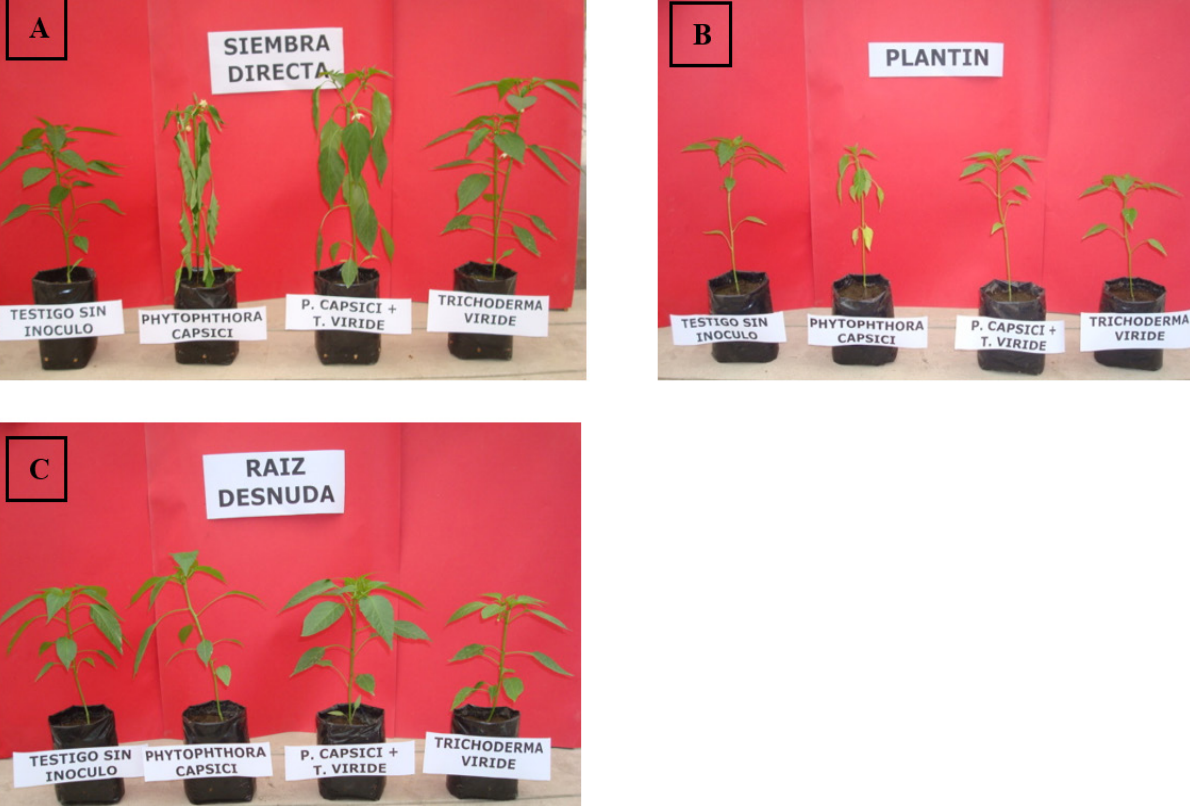
Figure 4. Paprika plants 76 days after sowing: A. Direct seeding (T1, T2, T3, T4); B. Plantlet (T5, T6, T7, T8) y C. Bare root (T9, T10, T11,